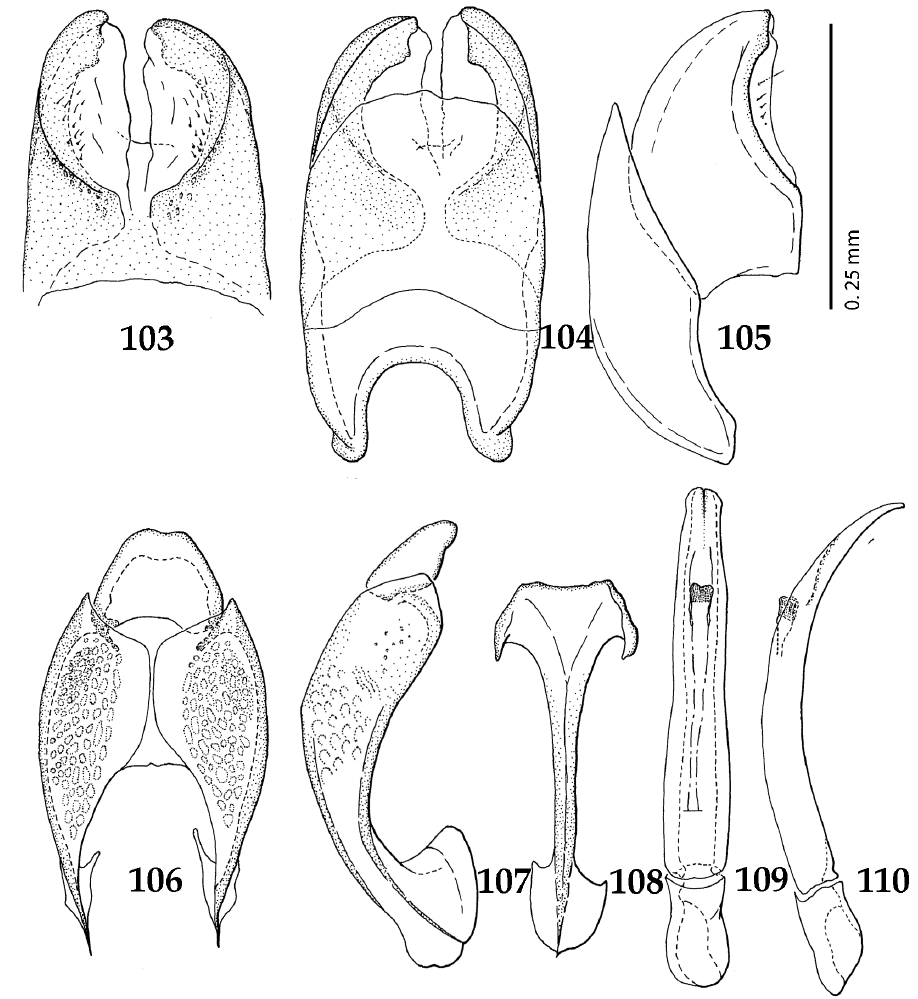
Figures 103–110. 103 Gnathoncus rotundatus (Kugelann, 1792) male terminalia after Ôhara (1994): 8 th sternite, ventral view 104 male terminalia: 8 th sternite + 8 th tergite, dorsal view 105 ditto, lateral view 106 male terminalia: 9 th + 10 th tergites, dorsal view 107 ditto, lateral view 108 male terminalia: spiculum gastrale, ventral view 109 male terminalia: aedeagus, dorsal view 110 ditto, lateral view. punctate. Pronotal depressions absent, almost entire dorsal surface in punctures.